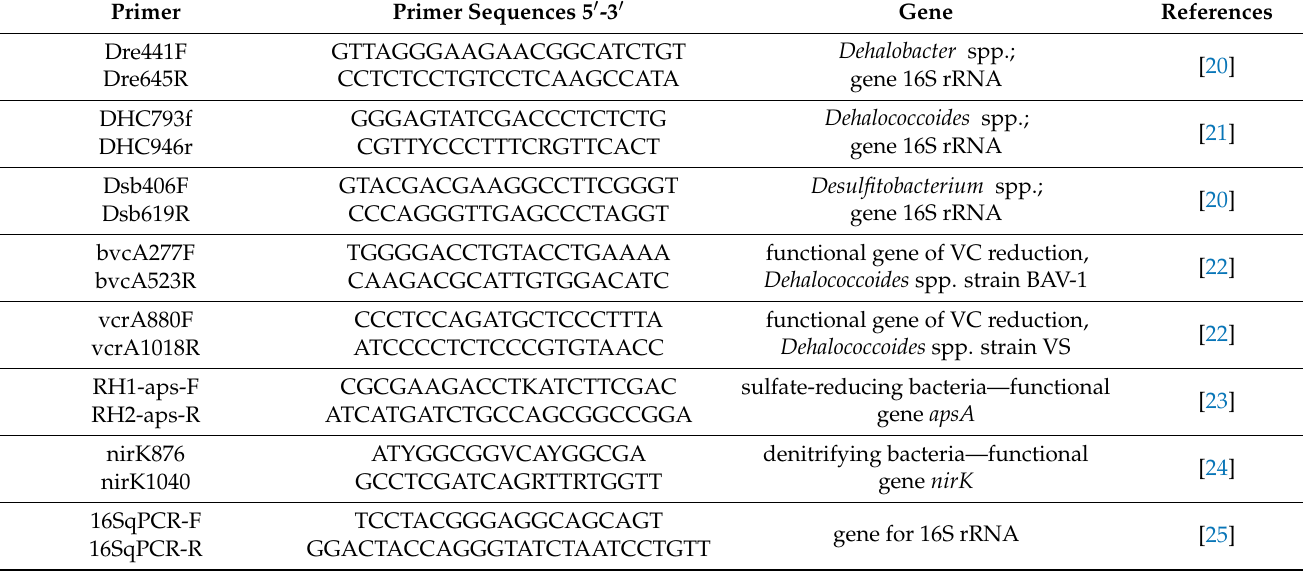
Table 2. qPCR and the detection of the following functional microbial groups were observed: (i) sulfate-reducing bacteria—functional gene apsA ; (ii) denitrifying bacteria—functional gene nirK ; dechlorinating bacteria—16S rRNA gene specific for Dehalococcoides spp., De- halobacter spp., Desulfitobacterium spp.; (iii) functional genes responsible for vinyl chloride reductive dehalogenation (genes bvcA and vcrA ) and (iv) total bacterial biomass expressed by 16S rRNA gene. Table 2. Primers used for